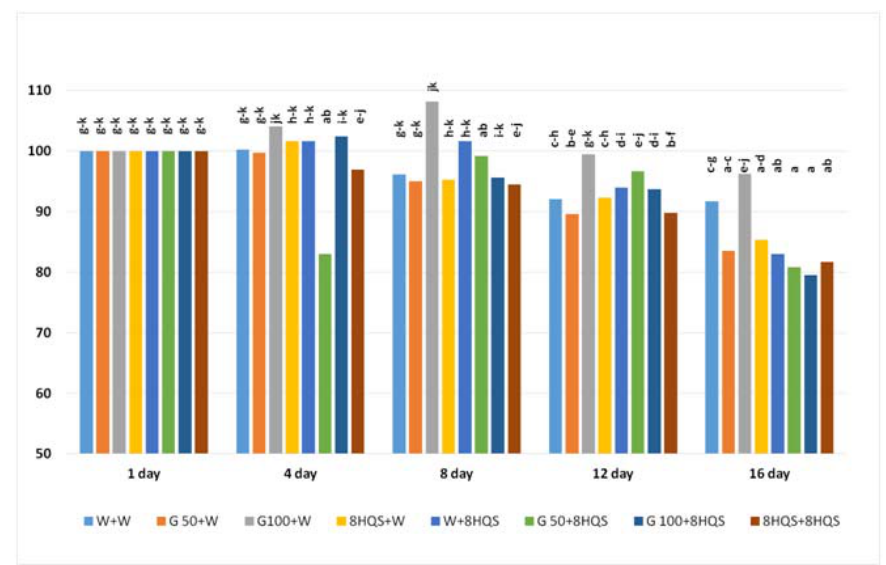
Figure 2. Effect of postharvest treatment on the SPAD chlorophyll content index change of Viola odorata leaves (%).